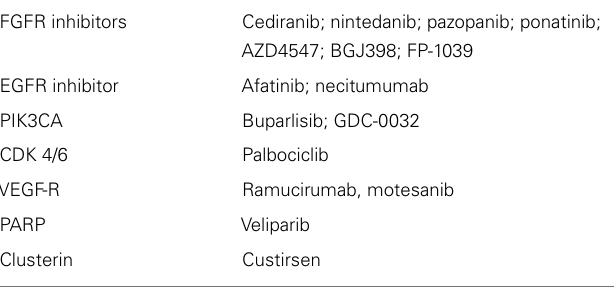
Table 2 |Alterations in major pathways in SqCC . Table 3 | Molecularly targeted drugs under investigation in Sqcc a